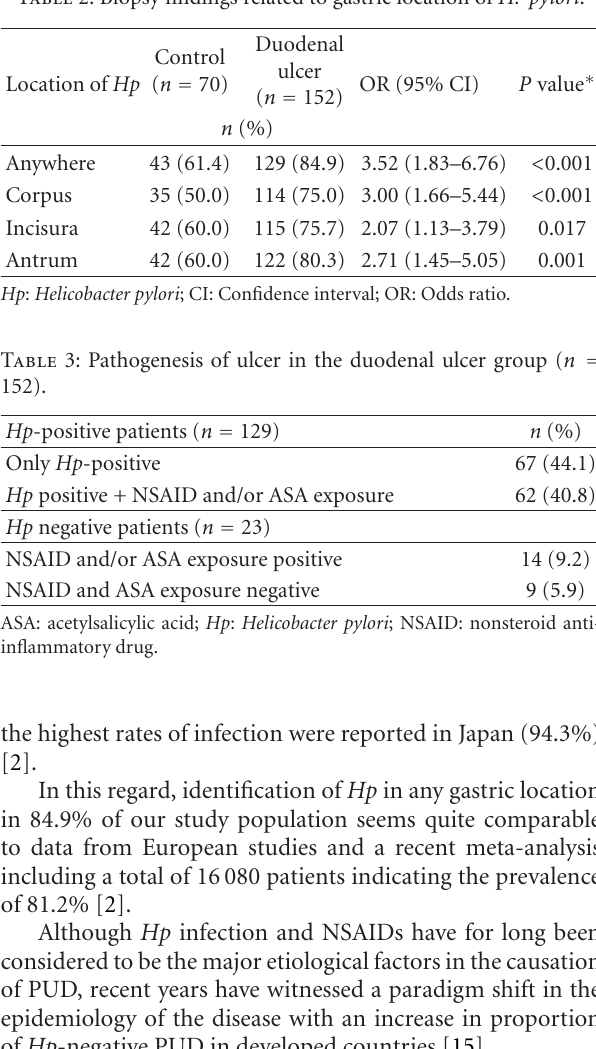
Table 2: Biopsy findings related to gastric location of H. pylori .